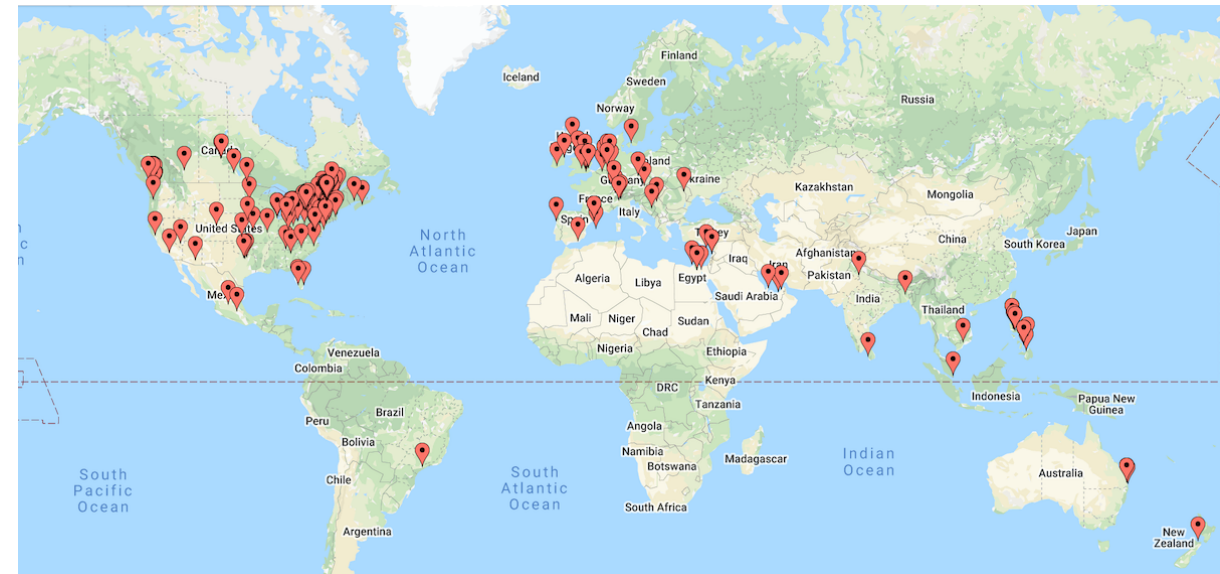
Figure 1. Geographic location of